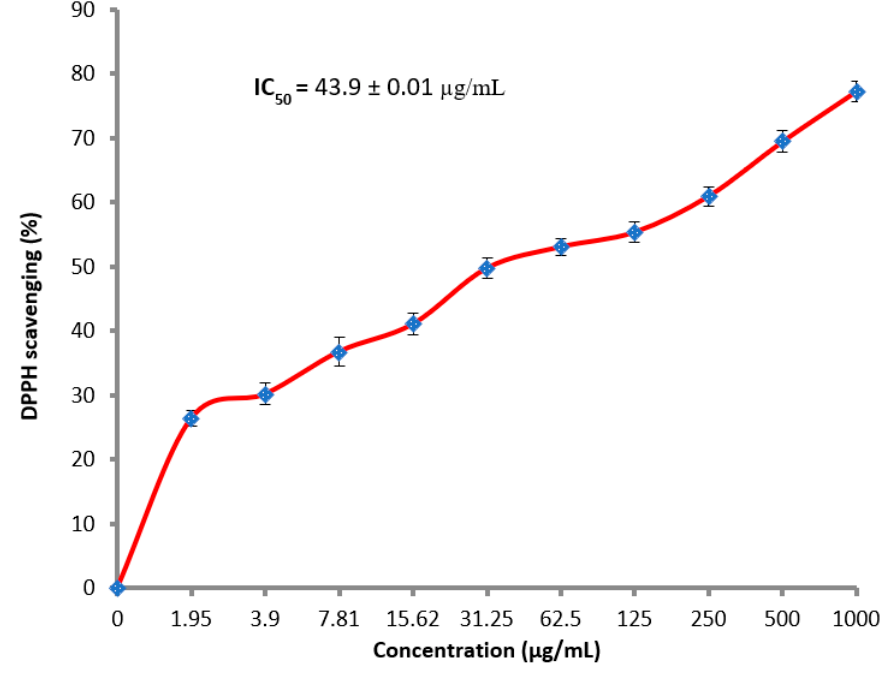
Figure 5. Antioxidant activity of latex.